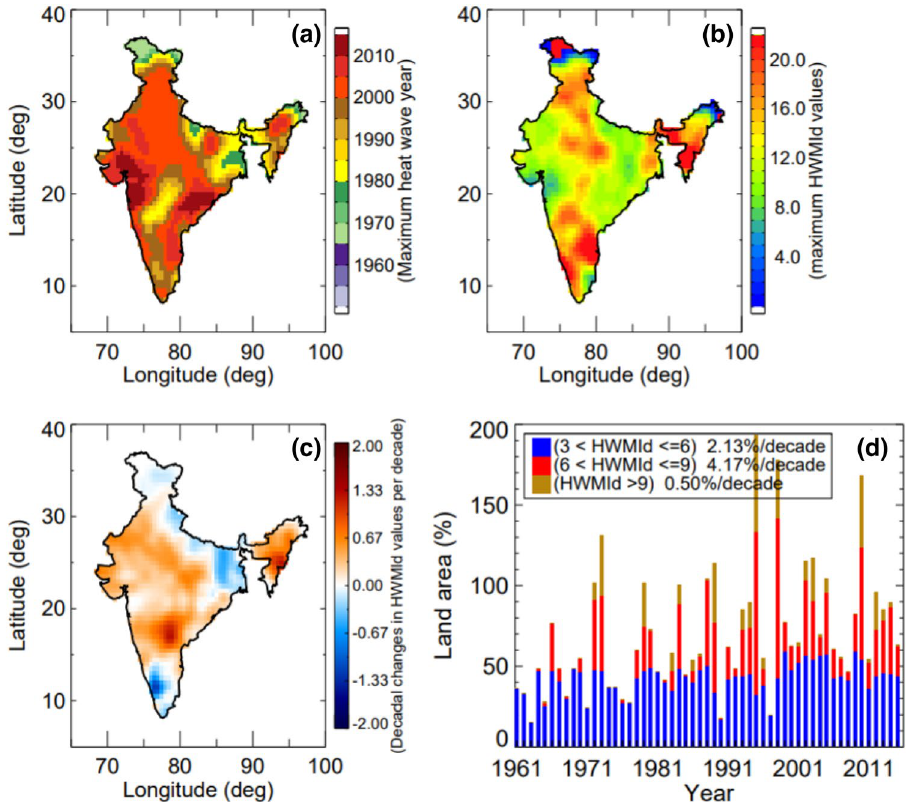
Figure 1. Spatial distribution of the observed Heat Wave Magnitude Index daily (HWMId) values estimated using IMD gridded data from 1961–2015. ( a ) Maximum heat waves occurred during the year based on HWMId values. ( b ) Maximum observed HWMId values. ( c ) Changes in HWMId values per decade. ( d ) Time series of percentage of the land area affected by heat waves over India (3 < HWMId ≤ 6; 6 < HWMId ≤ 9; HWMId > 9). (Figure was created using the Interactive Data Language (IDL) version 8.2 software, http:// www. harri sgeos patial. com/ docs/ whats_ new_ in_ 82.